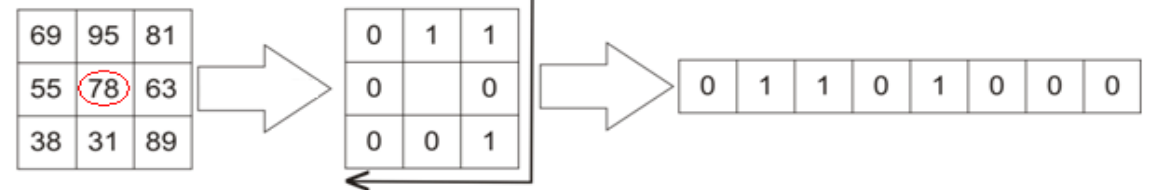
Figure 2. Example of counting of LBP